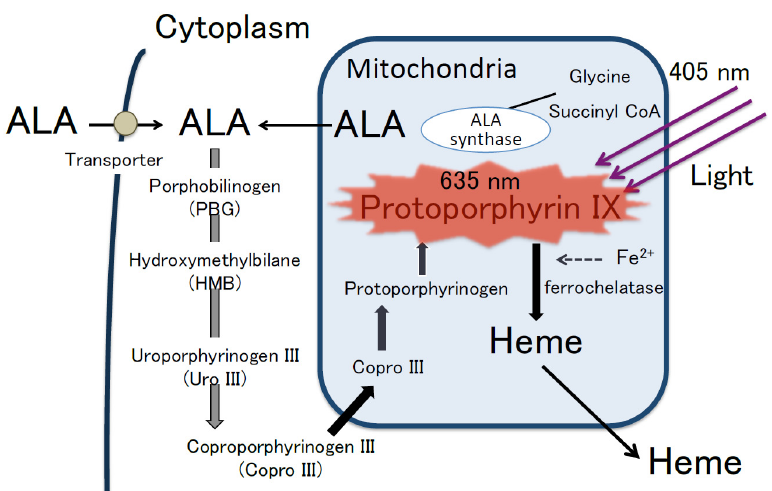
Figure 3. Heme biosynthesis pathway and mechanism of ALA-PDD. PpIX accumulates at higher levels in malignant cells than in normal cells. PpIX emit red fluorescence (635 nm) by blue light (405 nm). Modified from [53].